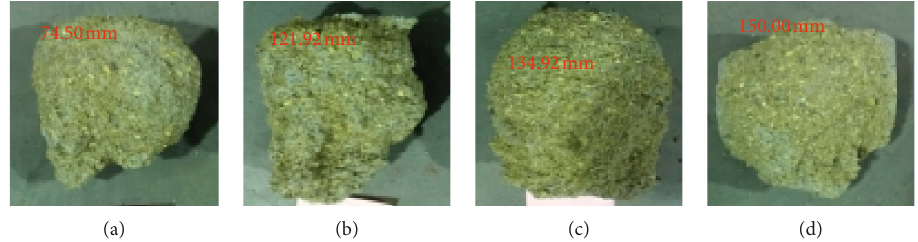
Figure 3: Shape of concretion of sample after different water-cement ratios of soil sample. (a) W / C � 0.5. (b) W / C � 0.6. (c) W / C � 0.8. (d) W / C � 1.0.